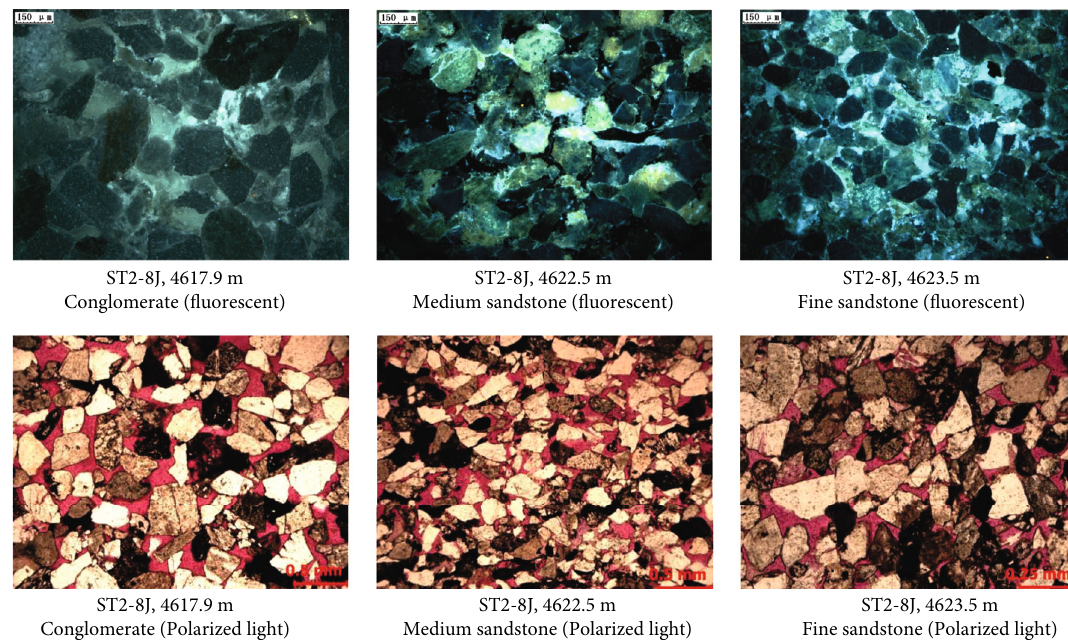
Figure 5: Thin section of core from TIII1 sand group in Sangtamu Oil fi